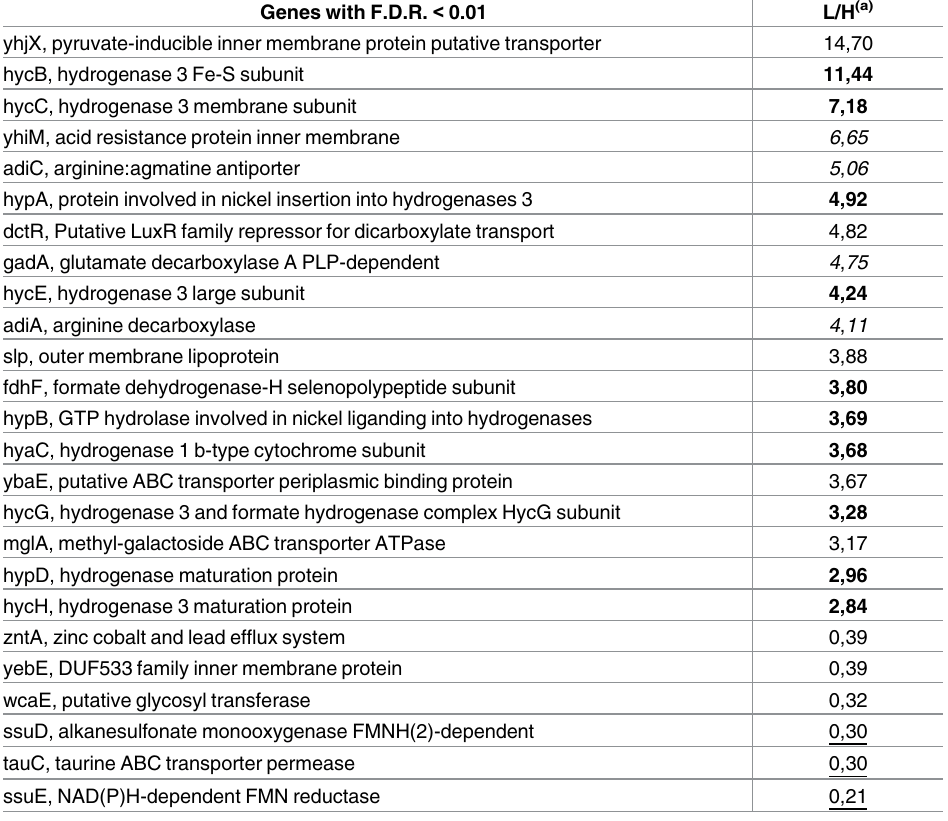
Table 1. Genes most affected in expression in biofilms under flow: low fluid dynamical regime (L) ver- sus high fluid dynamical regime (H). Secondcolumn is the ratio betweenmean normalizedtranscriptional expressions. Anaerobicmetabolismgenes (Bold), acid resistancegenes(Italic), Sulfate metabolismgenes (Underlined). Genes with F.D.R. <